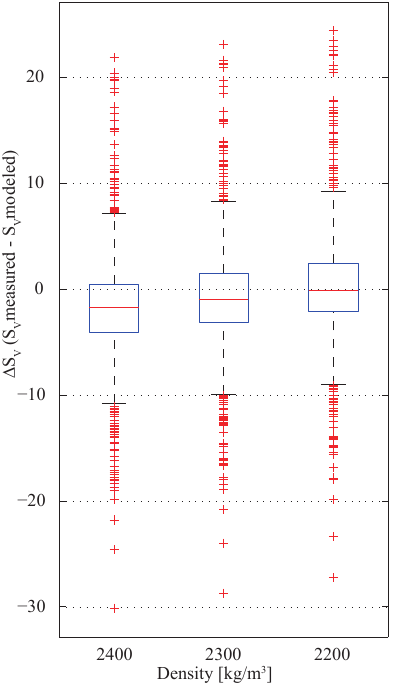
Figure 13. Boxplot of the varied density of the basin sediments – plotted is the (cid:49)S V . The median (cid:49)S V of the model with a density of 2200kgm − 3 is close to 0MPa and therefore the best-fit density to the available S V data, in contrast to the models with a higher basin density, where (cid:49)S V is negative (see Eq.